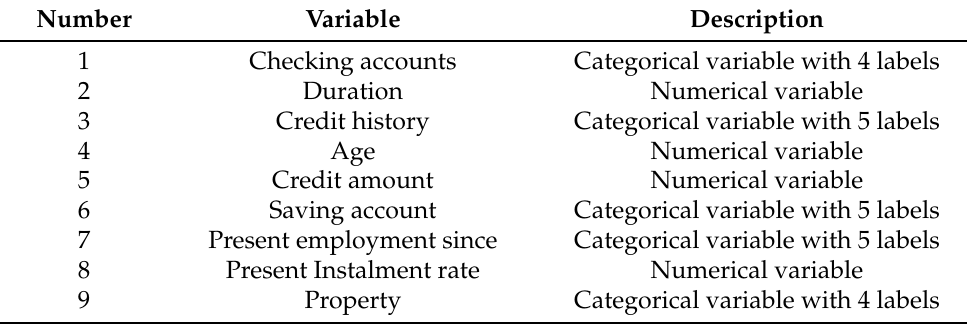
Table 7. The nine best predictors obtained via L1-based feature selection.